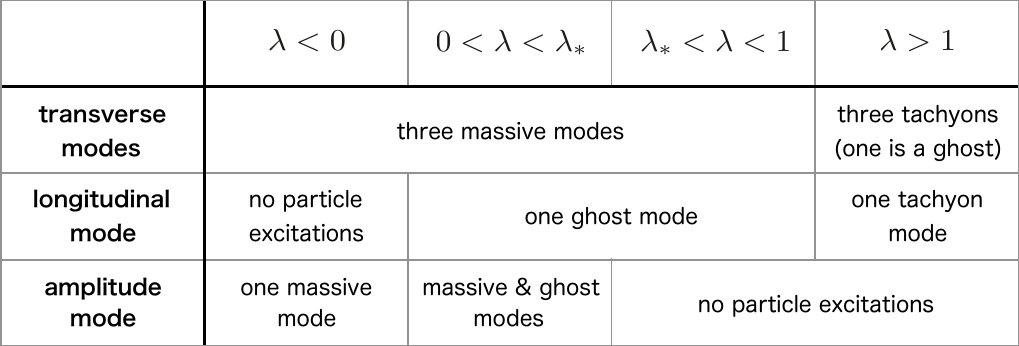
Figure 3 . Summary of the particle